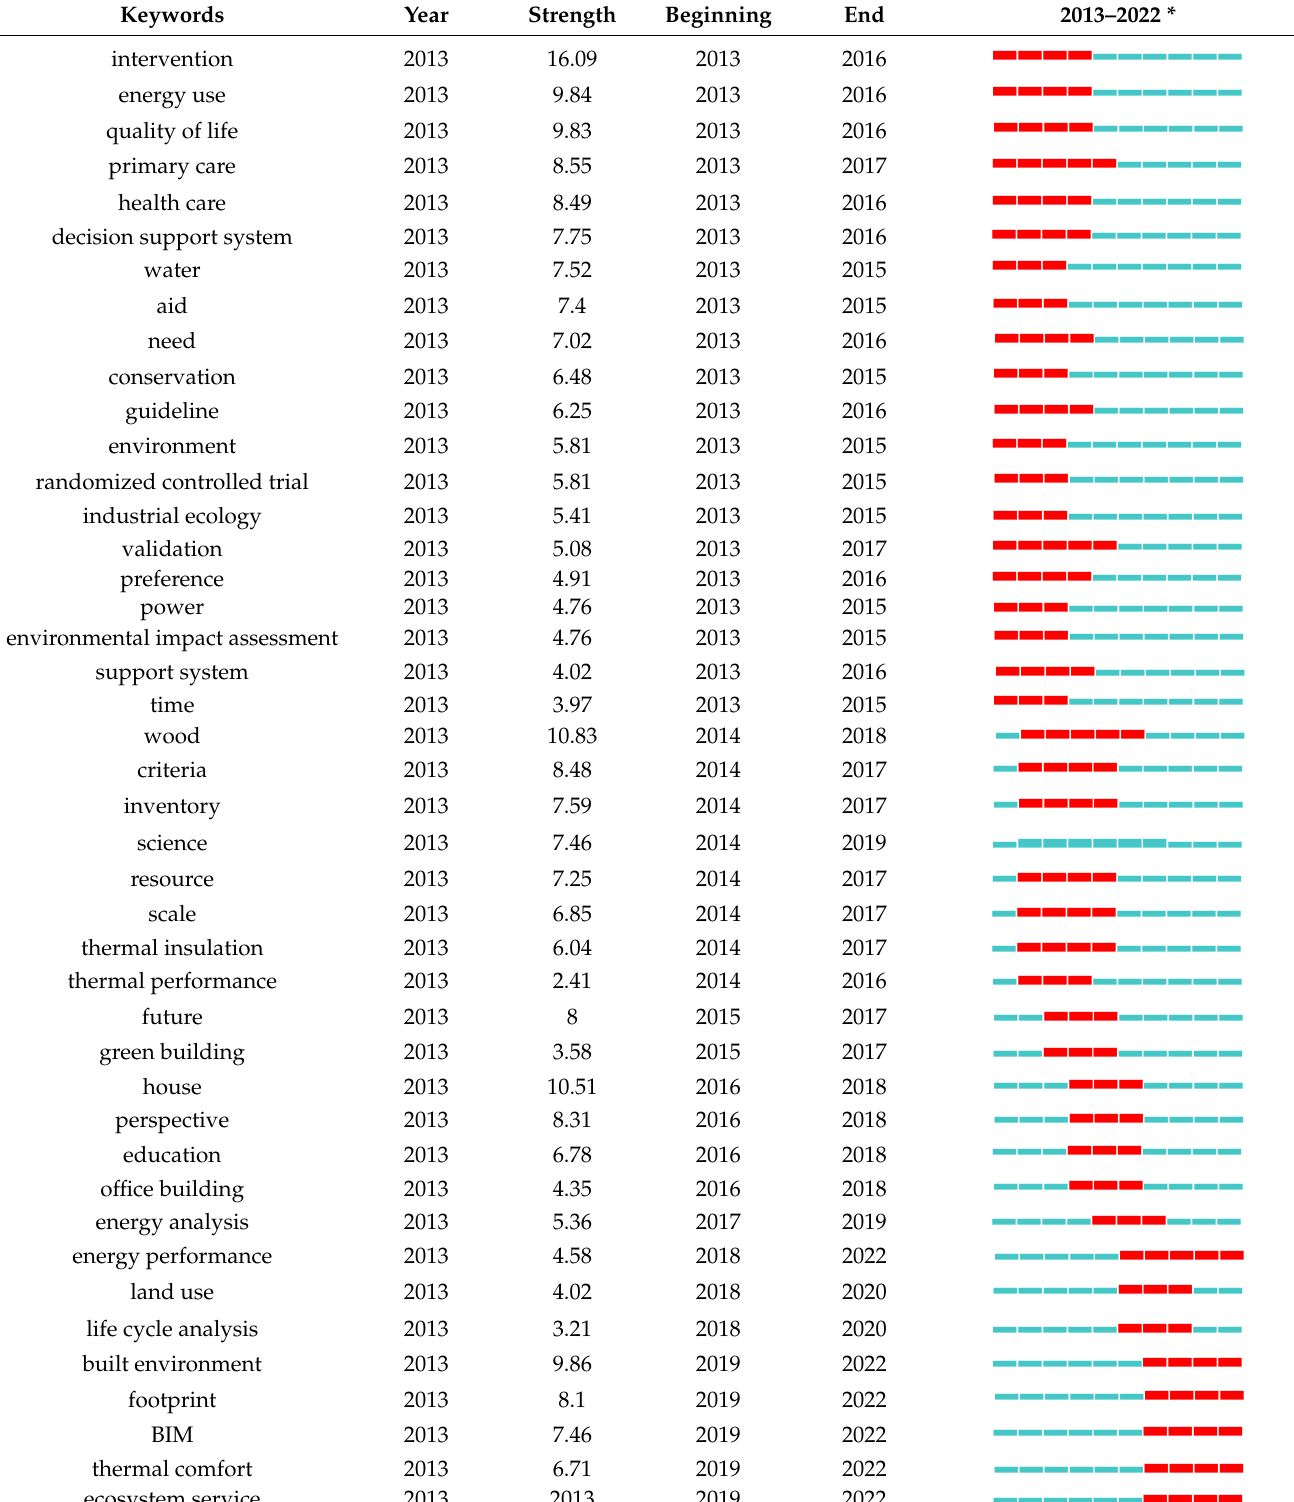
Table 1. Analysis of mutation words of building climate responsive design.